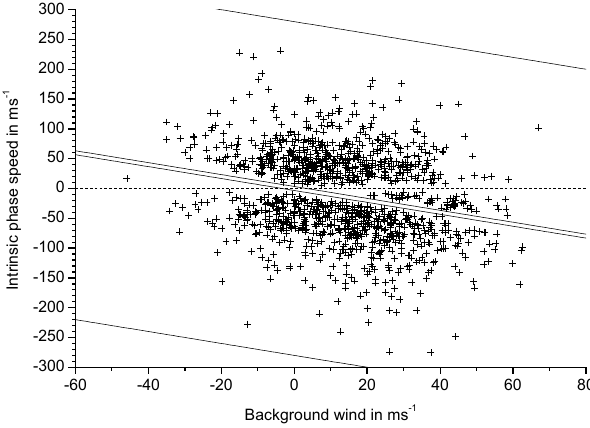
Fig. 7. Intrinsic horizontal phase speed vs. background Figure 7: Intrinsic horizontal phase speed vs. background wind.